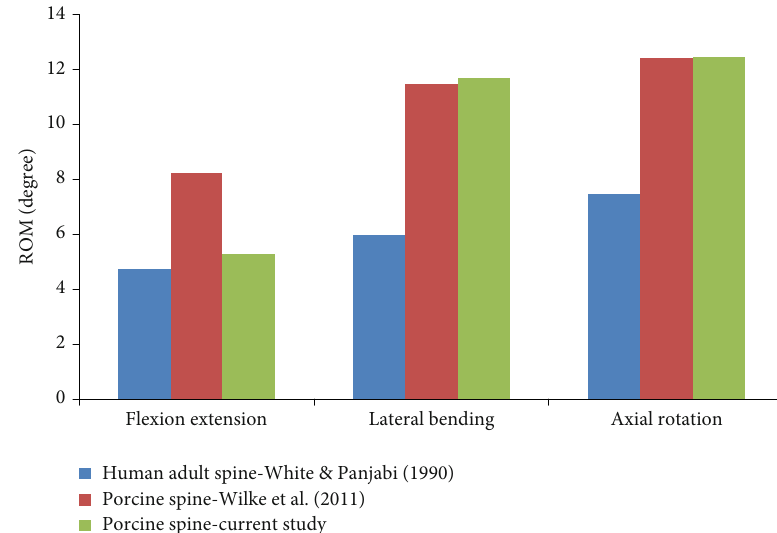
Figure 7: Comparison between porcine spine from current study and Wilke et al. [2] with human adult spine from White and Panjabi [29].